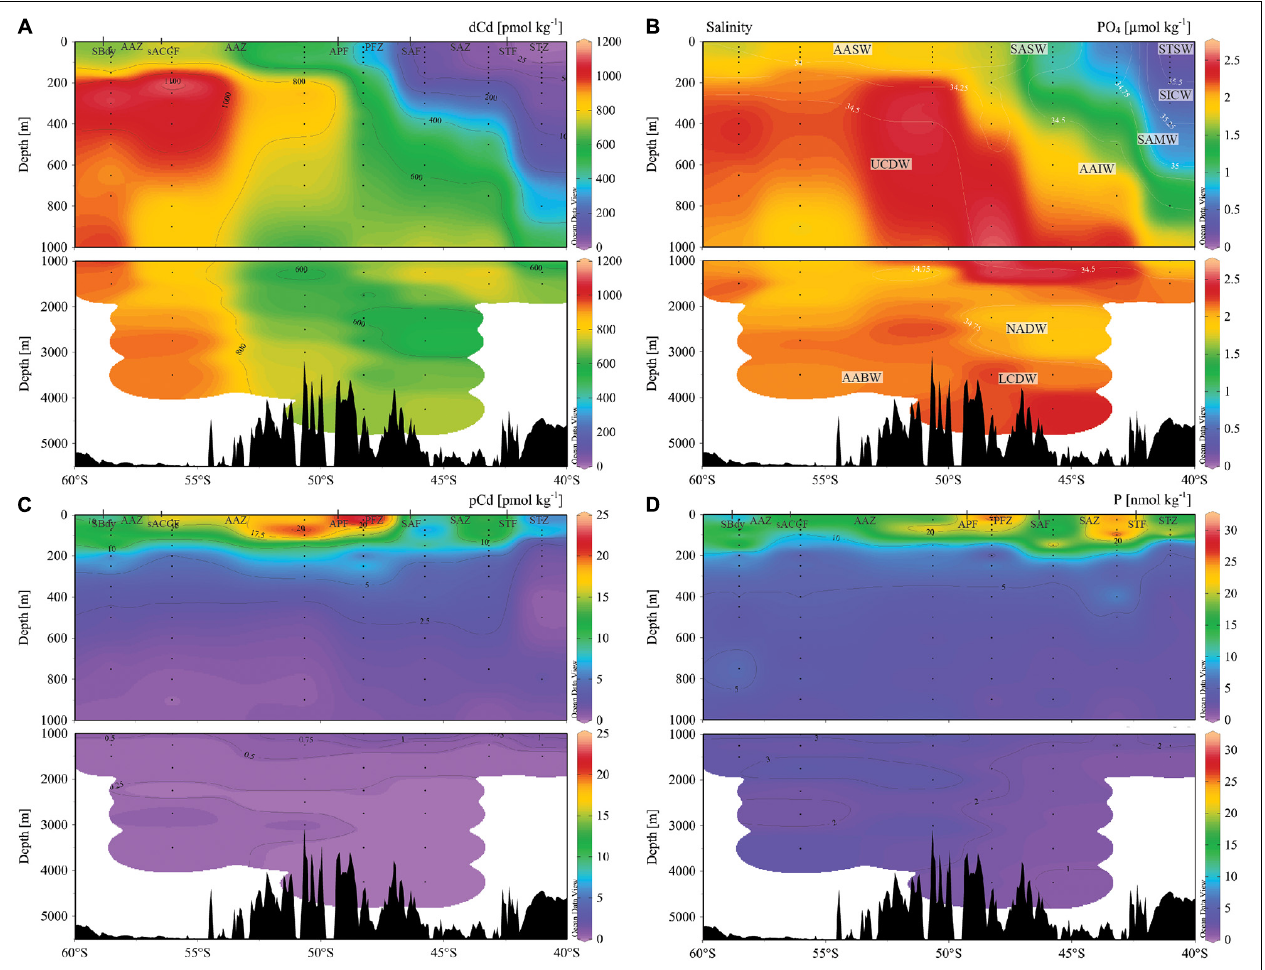
FIGURE 2 | Section plots of (A) dCd, (B) PO 4 overlain by salinity, (C) pCd and (D) P. Each figure is separated into upper 1,000 m (upper panel) and below 1,000 m (bottom panel) . Frontal positions, corresponding zones and water masses are shown (see Figure 1 for acronyms). Figure constructed using Ocean Data View (ODV; Schlitzer, 2020). PO 4 data from Weir et al.